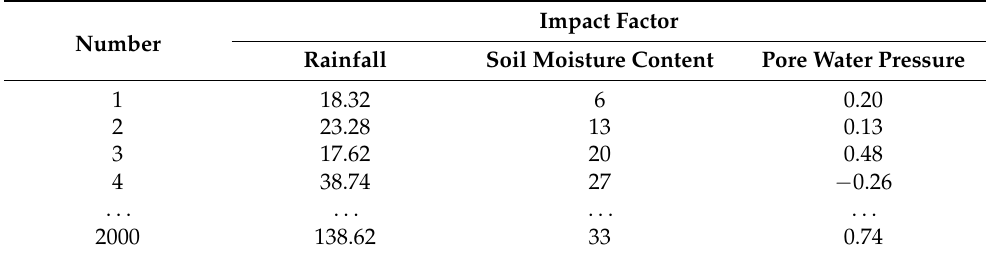
Table 3. Initial impact factor